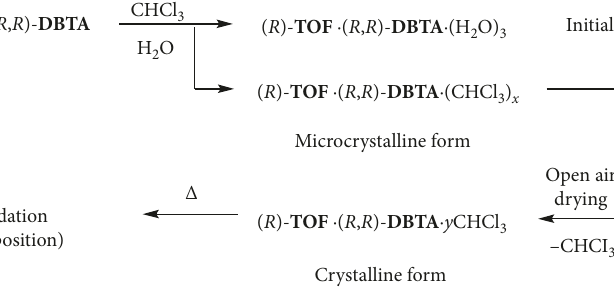
Scheme 5: Composition of the solid phase.